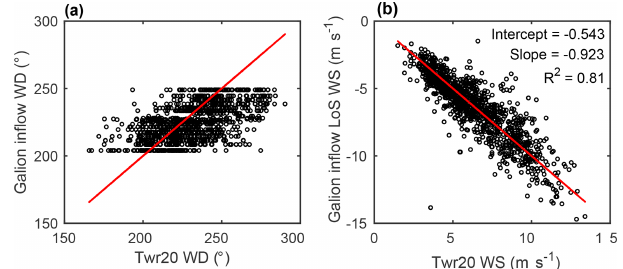
Figure 3. Comparison of 10min (a) inflow wind direction and (b) inflow wind speed at 78m height from scanning Doppler li- dar measurements (labelled Galion inflow) and those from the sonic anemometer deployed at 78m on Tower 20 (shown as Twr20). Note that the wind speeds reported by the Galion are radial line of sight velocities and are negative for flow towards the wind turbine. 1 : 1 lines are shown in red, while each dot represents a 10min period ( n =